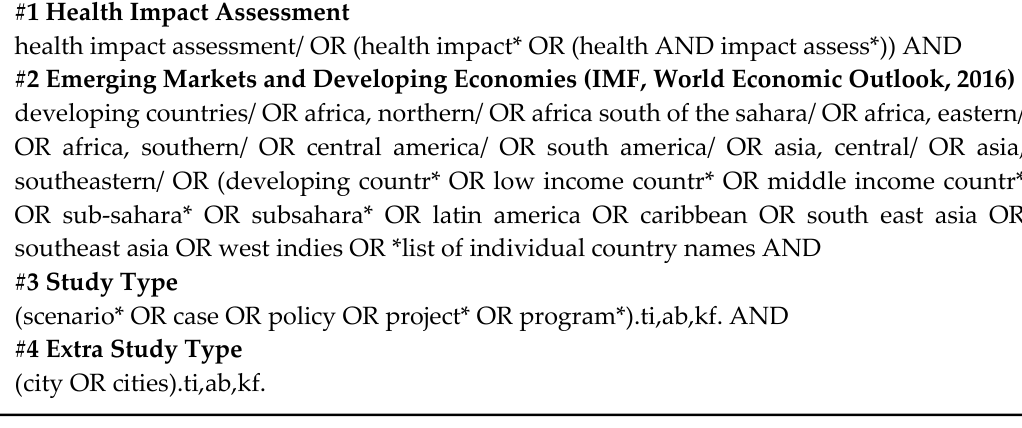
Figure 1. Search string used for the systematic review.